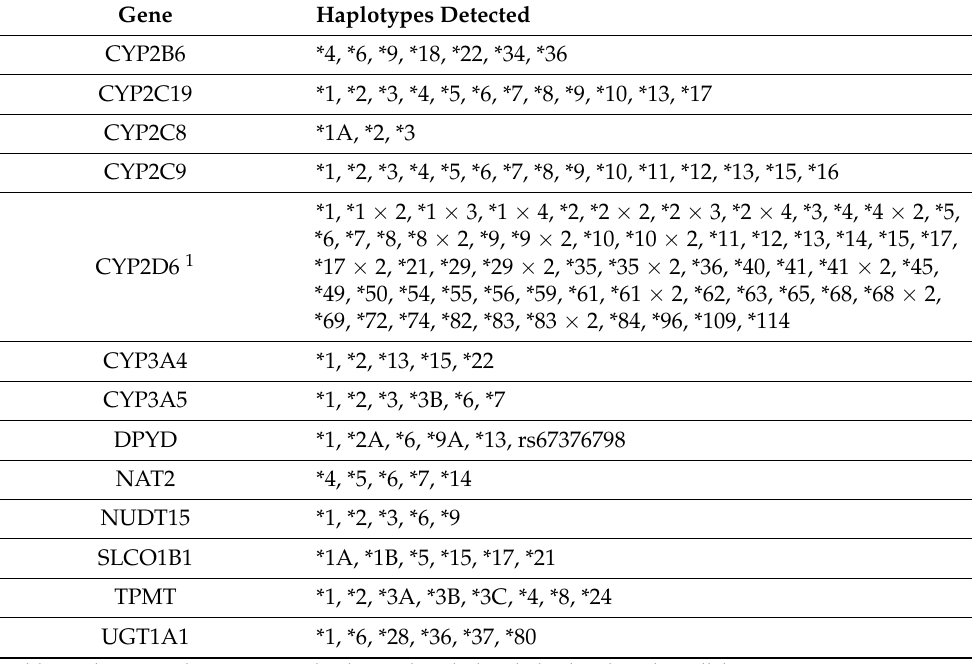
Table 7. Pharmacogenetic haplotypes detected by assay.